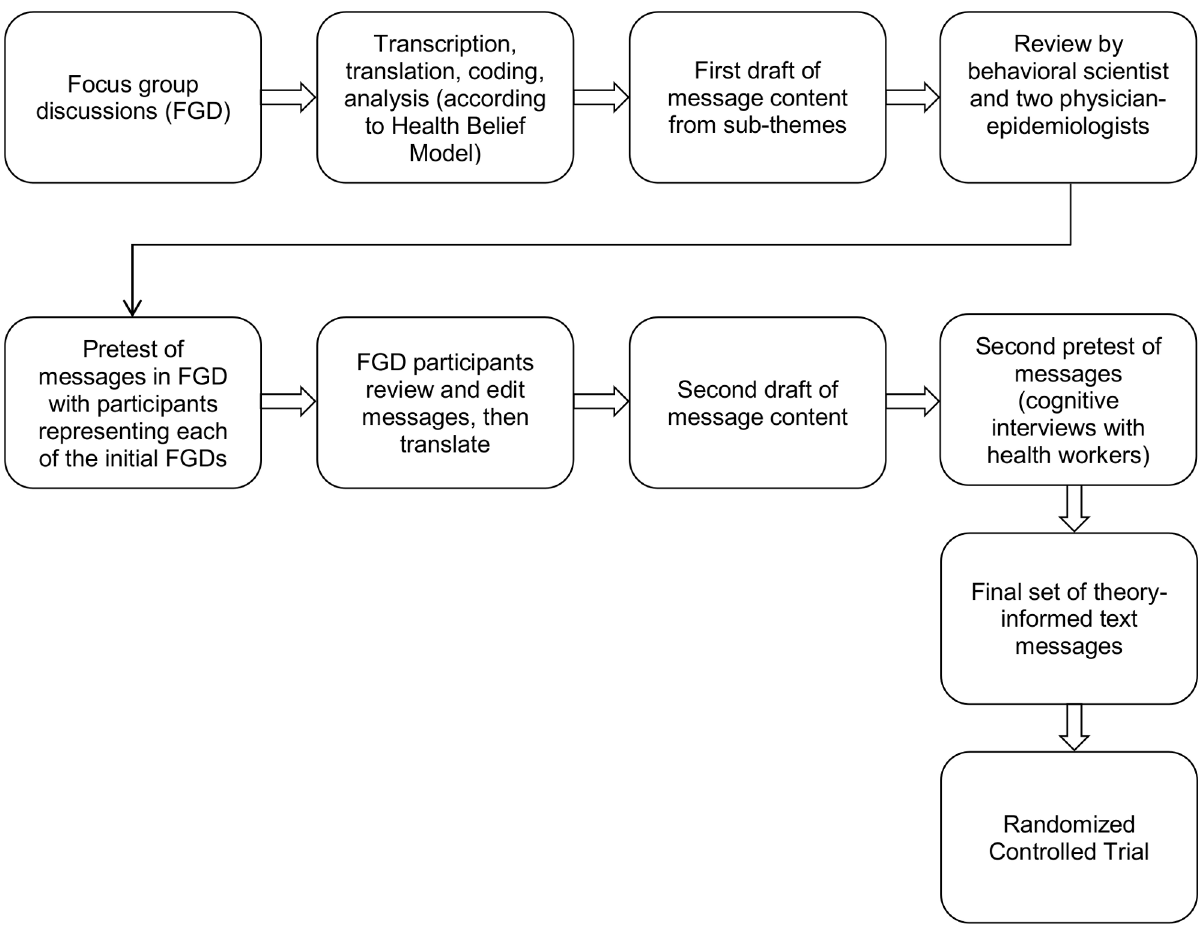
Figure 1. Process of crafting and refining text message content. HBM, Health Belief Model; FGD, Focus Group Discussion.